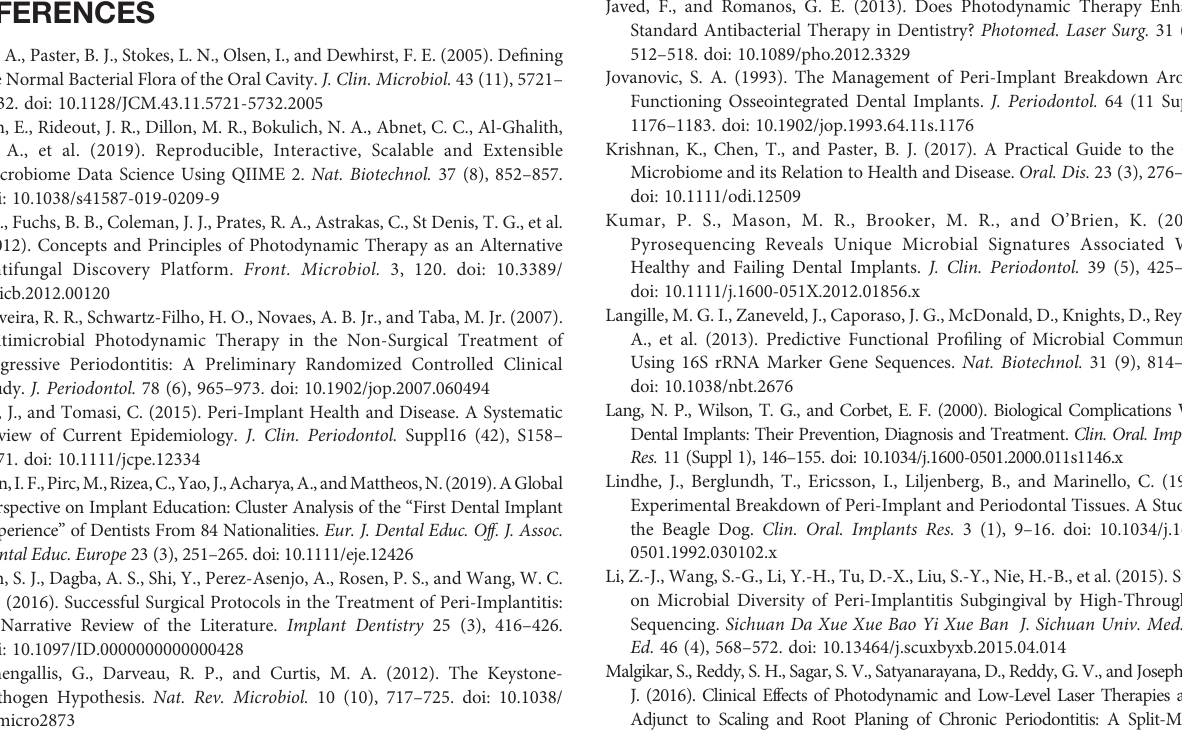
Supplementary Table S2 | Genera in co-abundance group used for network construction. Supplementary Table S3 | Genera with statistic signi fi cant between pre- treatment and 180 days after treatment.